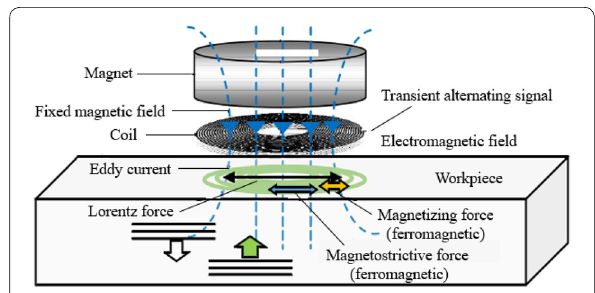
Figure 17 Working mechanism of EMAT [60, 61]